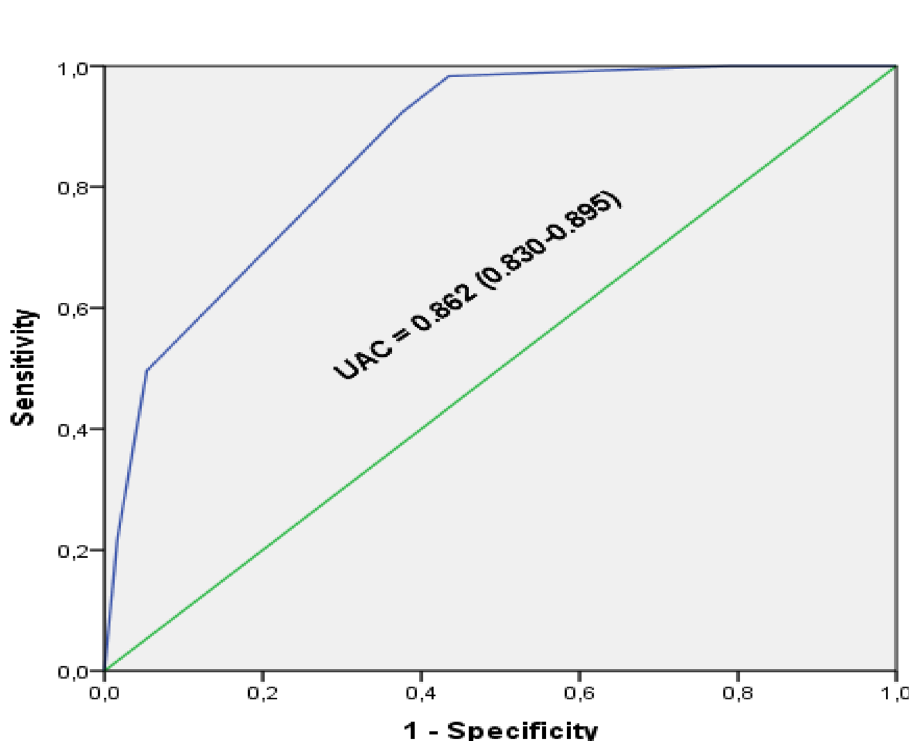
Figure 3. Diagnostic value of the EU-TIRADS score using the ROC